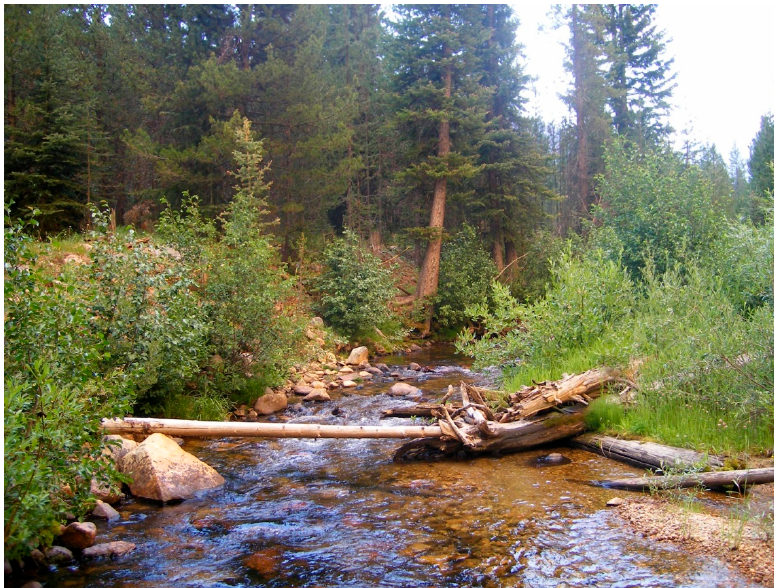
Diversity 2021 , 13 , x FOR PEER REVIEW Figure A3. Downstream-reach in summer 2007. Photo by Robert Arkle. Figure A3. Downstream-reach in summer 2007. Photo by Robert Arkle.